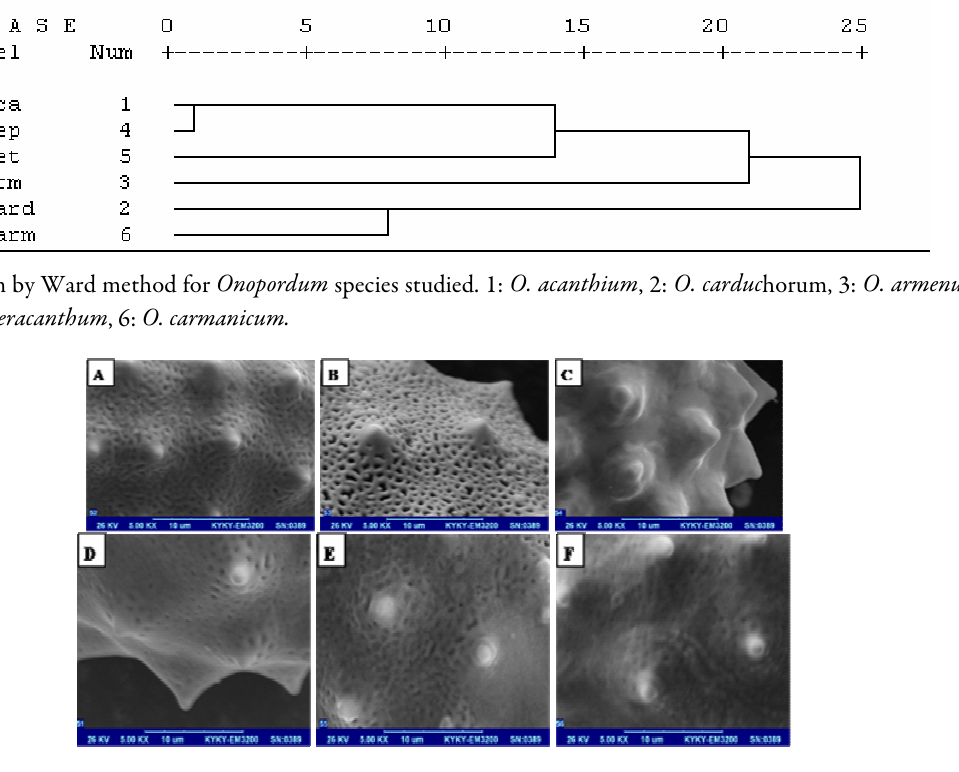
Fig. 9. SEM picture of exin in species of Onoporpum : (A): O. acanthium, (B): O. carduchorum, (C): O. armenum, (D): O. leptolepis , (E): O. heteracanthum , (F): O. carmanicum . (X=